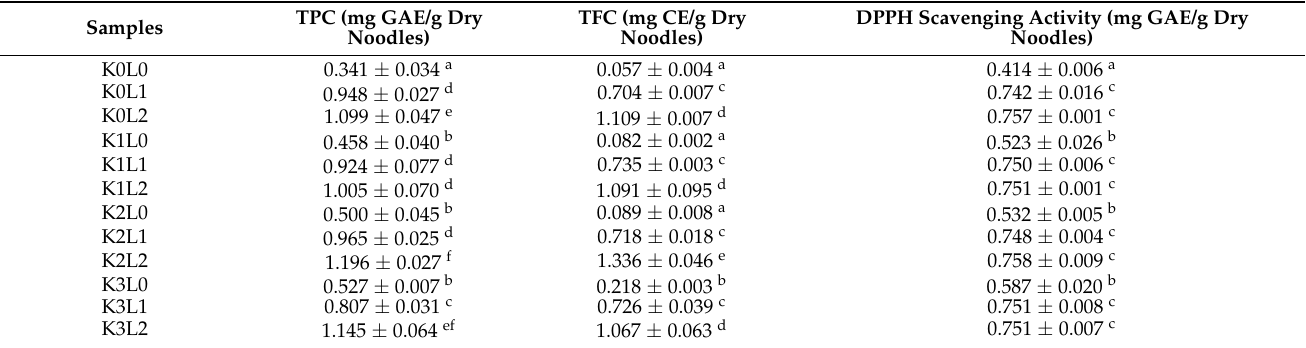
Table 4. Total phenol content, total flavonoid content, and the DPPH free radical scavenging activity of the stink lily